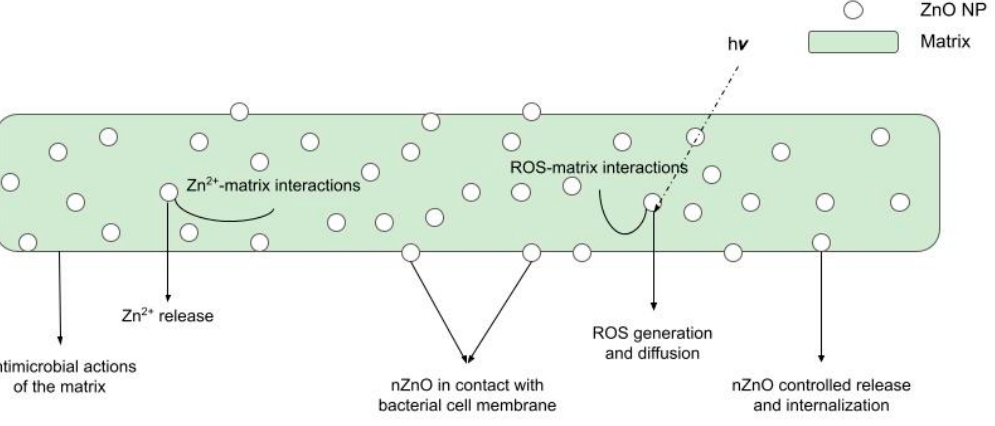
Figure 5. Possible antibacterial action mechanisms of BNCs.